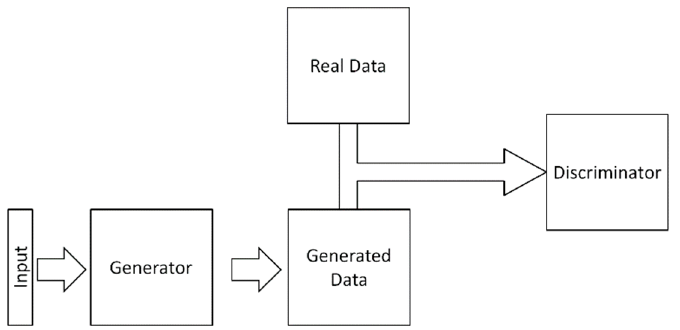
Figure 9. Generative adversarial network.